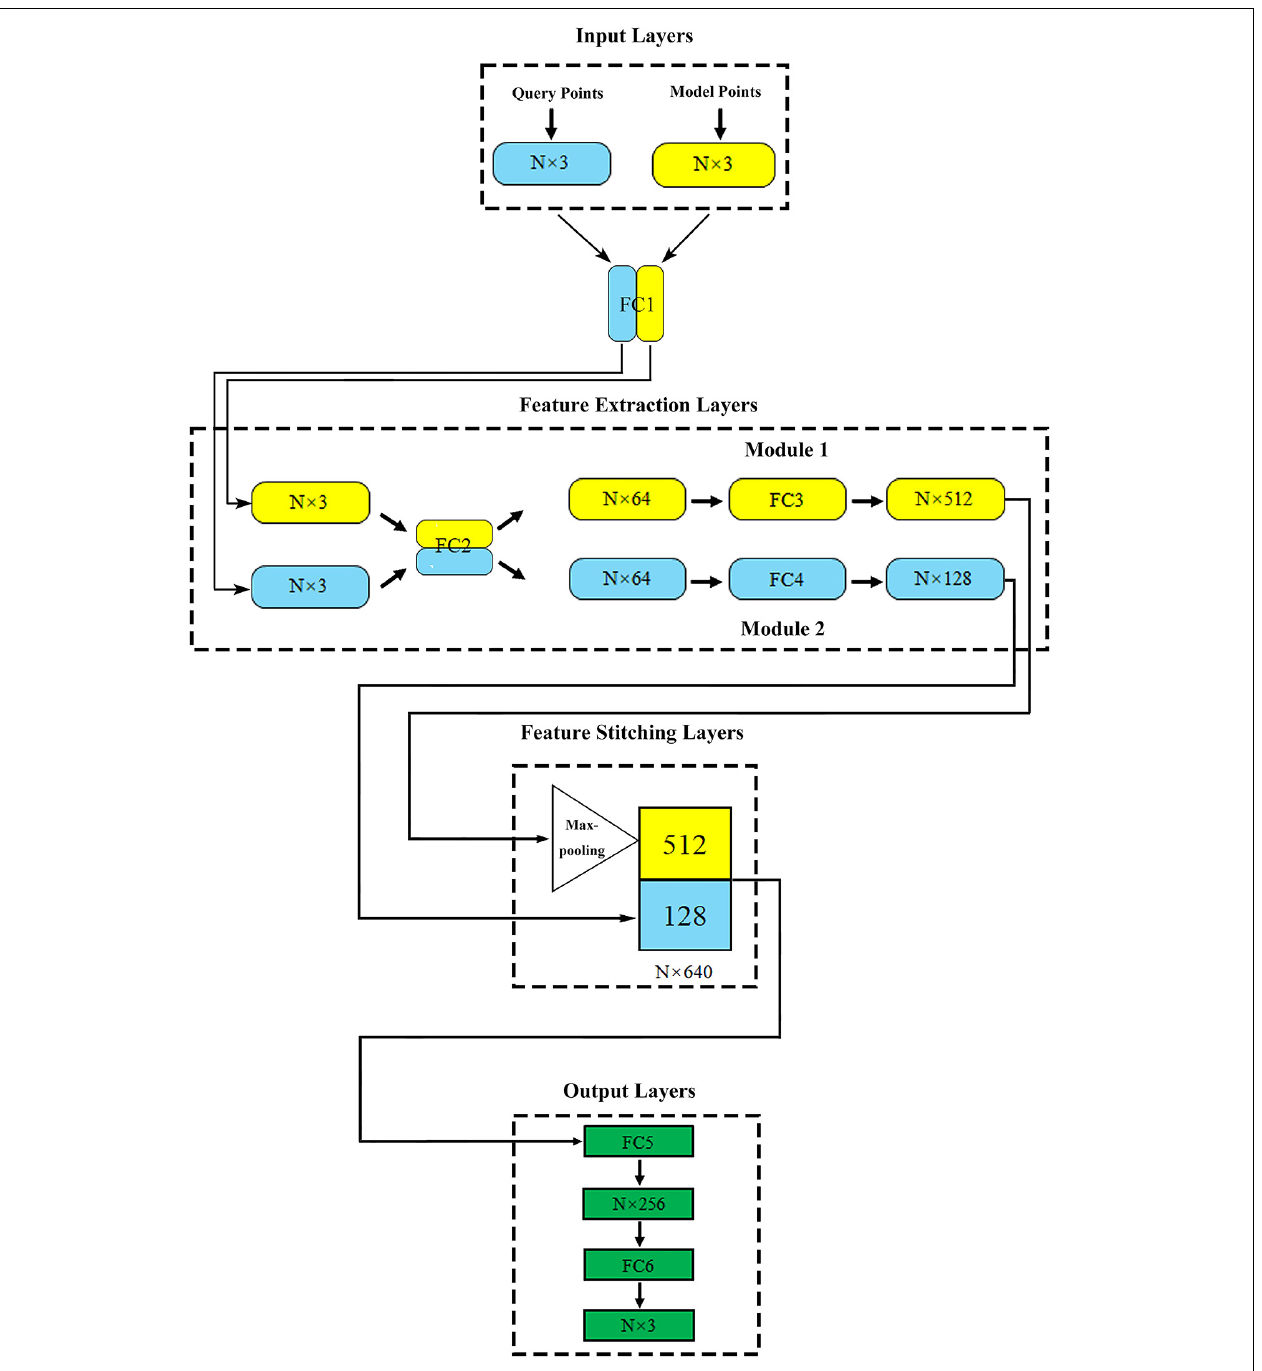
FIGURE 2 | The proposed network structure. N (in millions) represents the total number of points contained in the query point cloud and the model point cloud in one model.